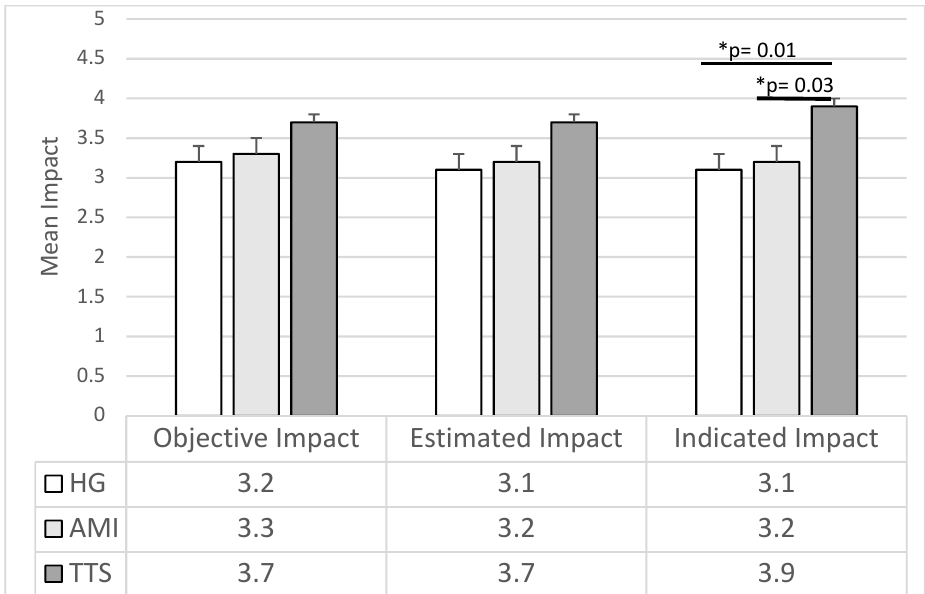
Figure 1. Mean and Std. Err. of the Impact of Life Events reported by the three groups of participants ( p refers to ANCOVA results). HG: Healthy Group; AMI: Acute Myocardial Infarction; TTS: Takotsubo Syndrome. Table 3. Statistical results of the Impact of Life Events indices reported by the